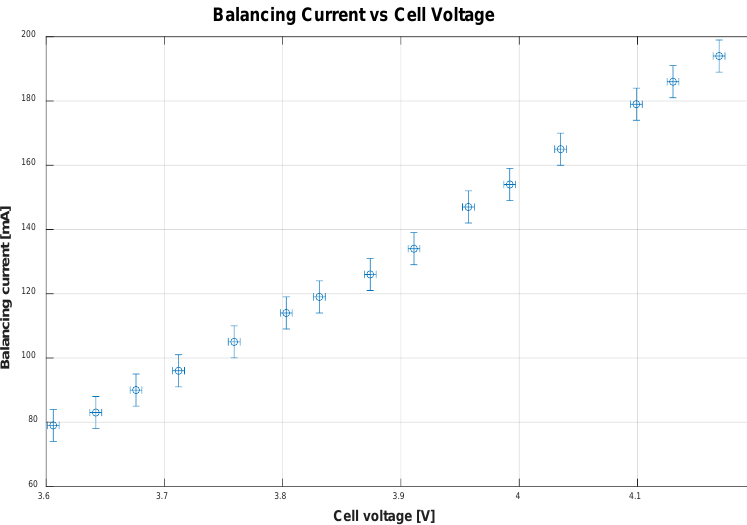
Figure 14. Dependence of balancing current on Cell voltage.